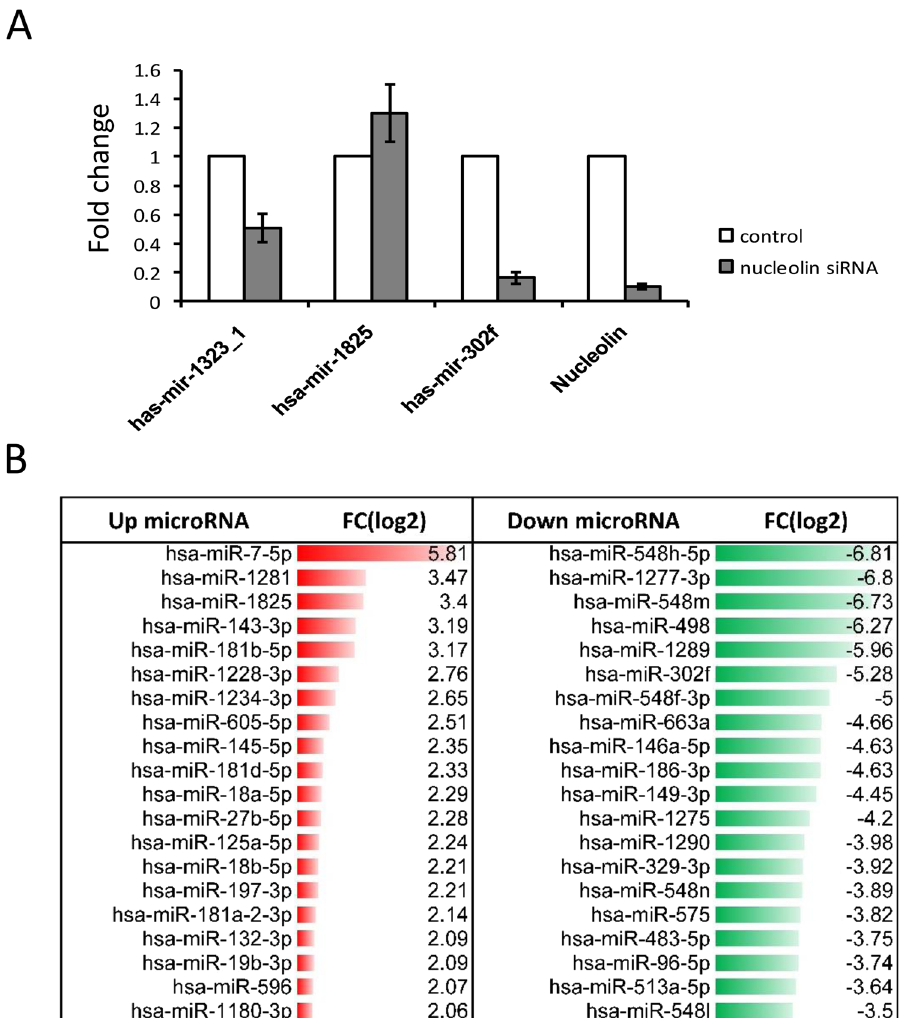
Figure 7. miRNAs expression analysis in NCL depleted HeLa cells. ( A ) Fold change of randomly selected miRNAs (Upregulated Hsa-miR-1825 and down regulated hsa-miR-1323 -hsa-miR-302f and NCL) as determined by RT-qPCR. ( B ) First 20 differentially expressed (Up/Down) microRNAs with FC ≥ ± 1.5 and p-value ≤